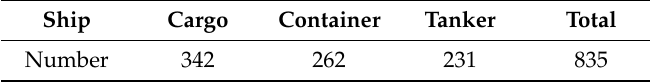
Figure 4. The process of making high-resolution Synthetic Aperture Radar (SAR) ship slices. Table 1. Gaofen-3 (GF-3) high resolution ship